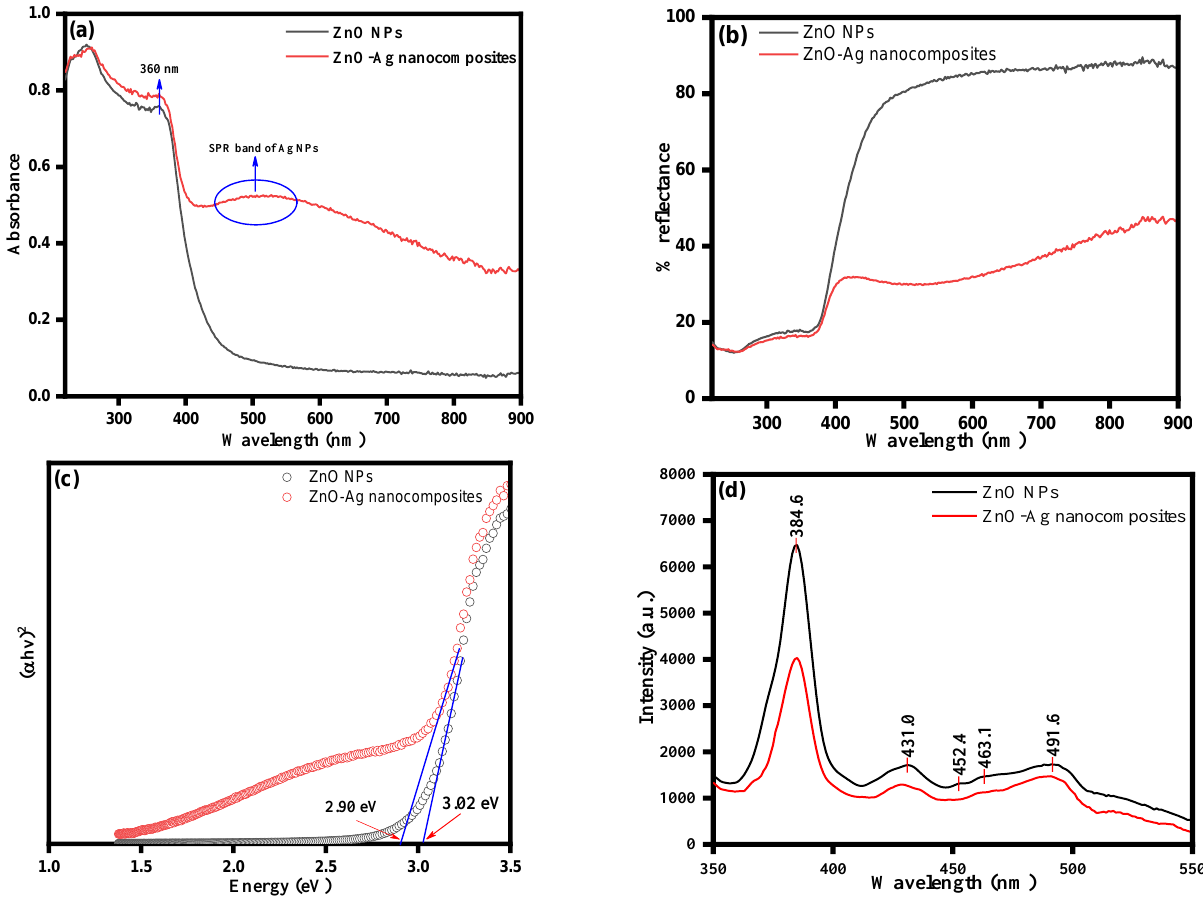
Figure 4. ( a ) UV – Visible DRS spectra, ( b ) reflectance spectra, ( c ) bandgap energy (Eg) (αhv) 2 vs. Figure 4. ( a ) UV–Visible DRS spectra, ( b ) reflectance spectra, ( c ) bandgap energy (Eg) ( α hv) 2 vs. energy (eV), and ( d ) PL spectra of ZnO NPs and ZnO – Ag nanocomposite. energy (eV), and ( d ) PL spectra of ZnO NPs and ZnO–Ag